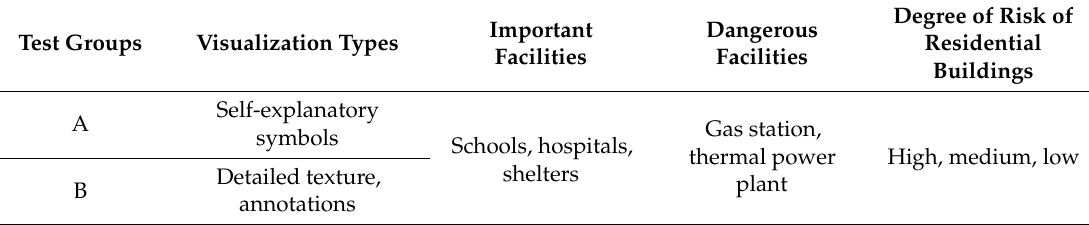
Table 2. Experimental scene objects.